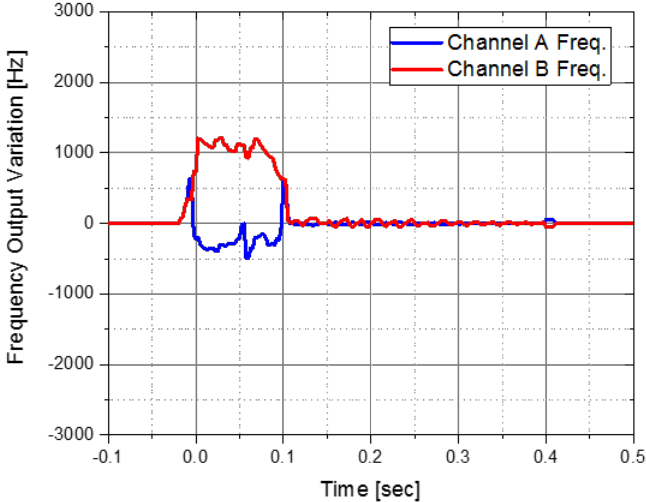
Figure 8. Accelerometer frequency output from IMU with 4-point fixed isolator.